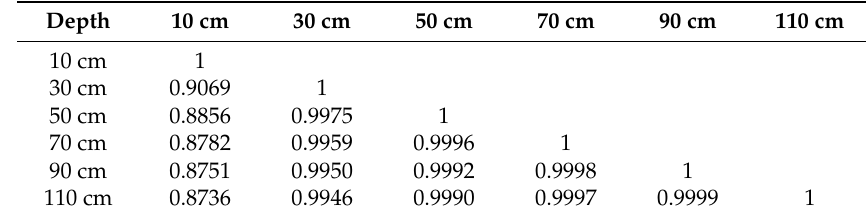
Table 2. Correlation relationship of soil moisture variable at different depths in the soil profile (n = 3796). Depth 10 cm 30 cm 50 cm